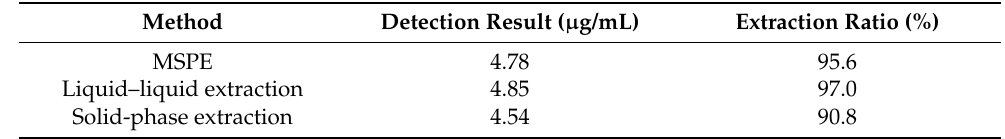
Table 2. Comparison of MSPE with liquid–liquid extraction and solid-phase